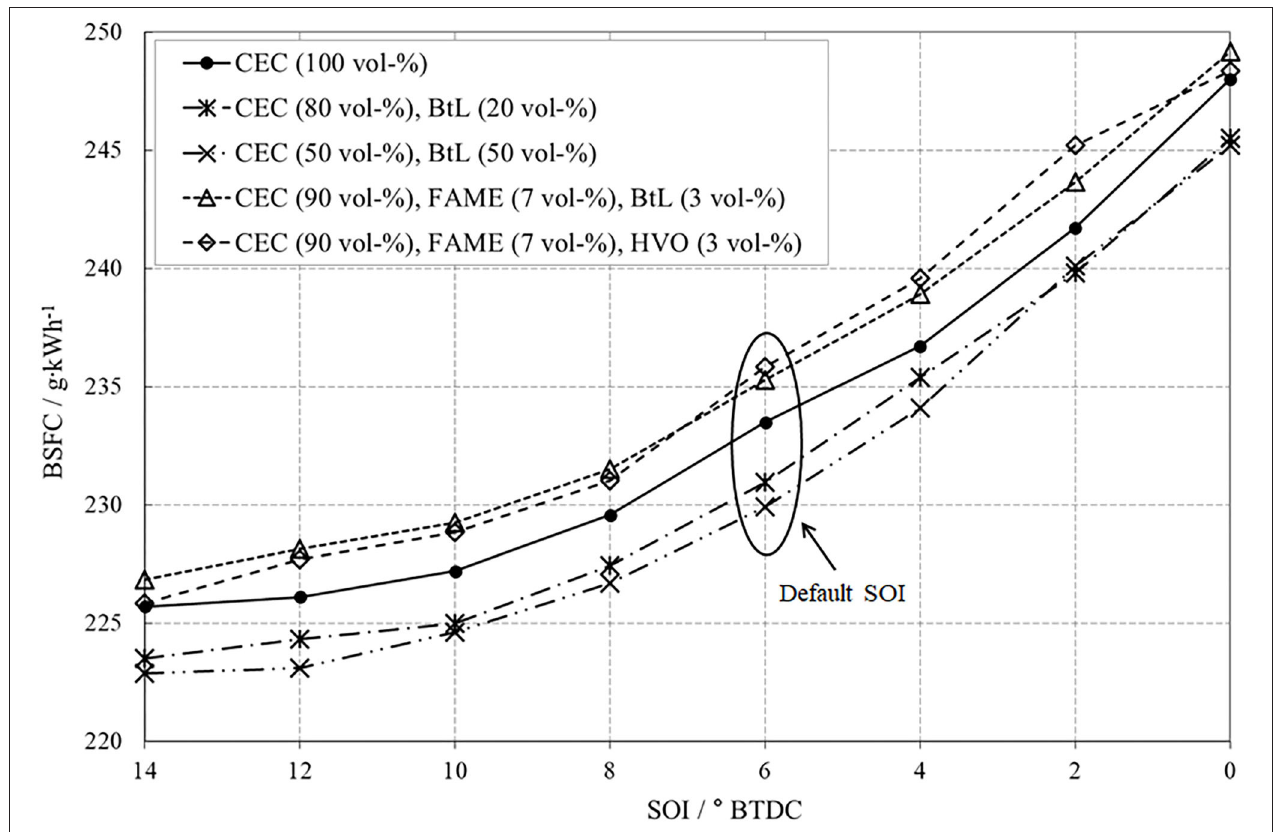
FIGURE 12 | BSFC at 3,000 min − 1 and 8 bar BMEP with varying